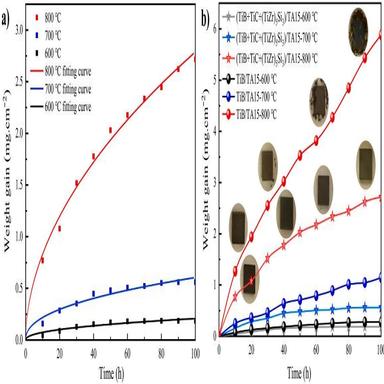
Oxidation kinetics of the composites oxidized at 600, 700 and 800 ◦C for 100 h: (a) mass gain-time data and fitting curves of the (TiC+TiB+(TiZr)5Si3)/TA15 composites, (b) mass gain-time curves of the TiB/TA15 composites and the (TiC+TiB+(TiZr)5Si3)/TA15 composites with macrographs inserted.